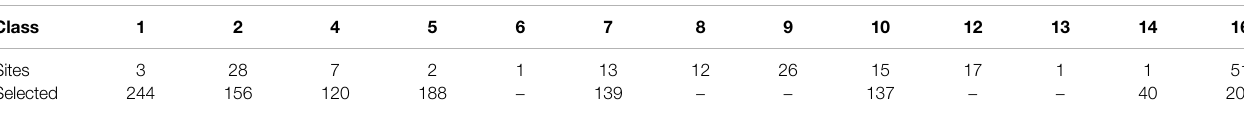
TABLE 1 | Number of BELMANIP sites for each IGBP class. Classes with no corresponding sites were removed from the table for brevity (classes 3, 11, and